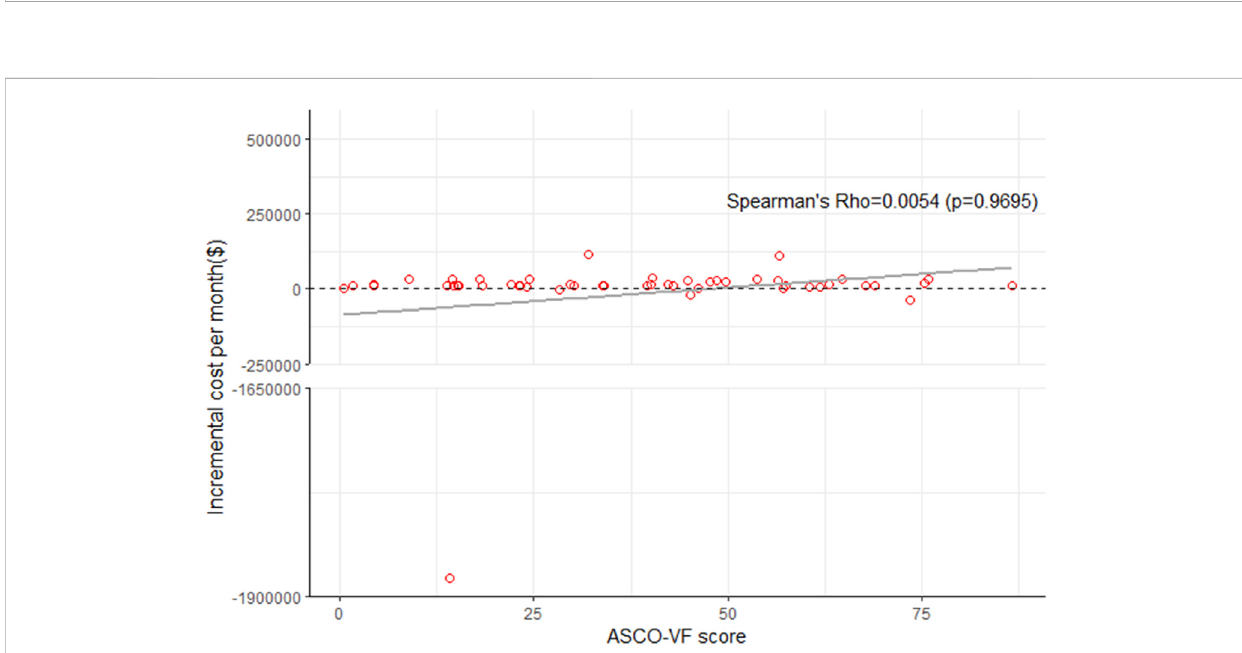
FIGURE 2 Scatterplot of six immune checkpoint inhibitors between ASCO-VF scores and incremental cost per month in all